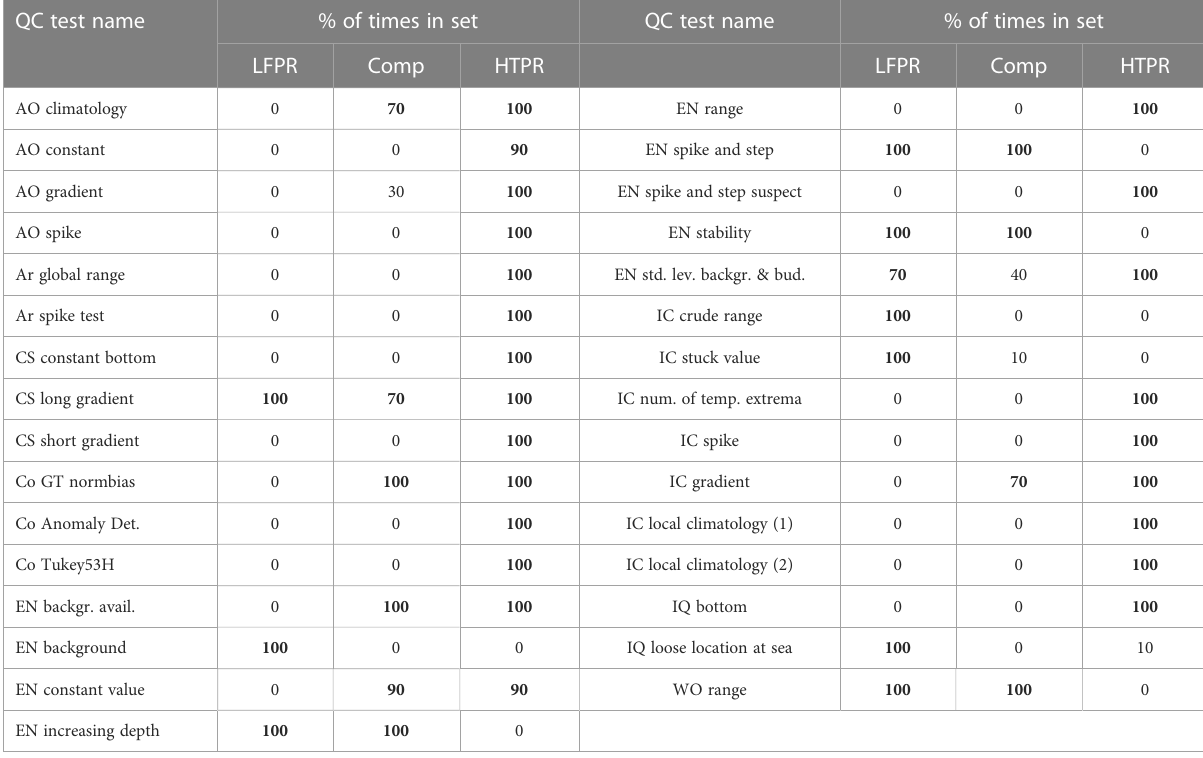
TABLE 5 Percentage of times each test appears in the QC sets derived in the 10-fold cross-validation. QC test